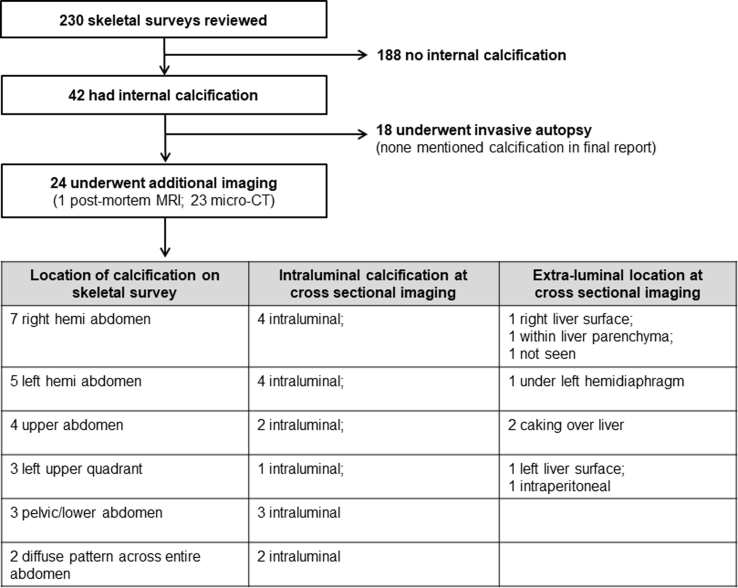
Flowchart demonstrating the total number of cases reviewed, and those that were subsequently found to have internal calcifications with their corresponding location, as seen on further post-mortem cross sectional imaging.